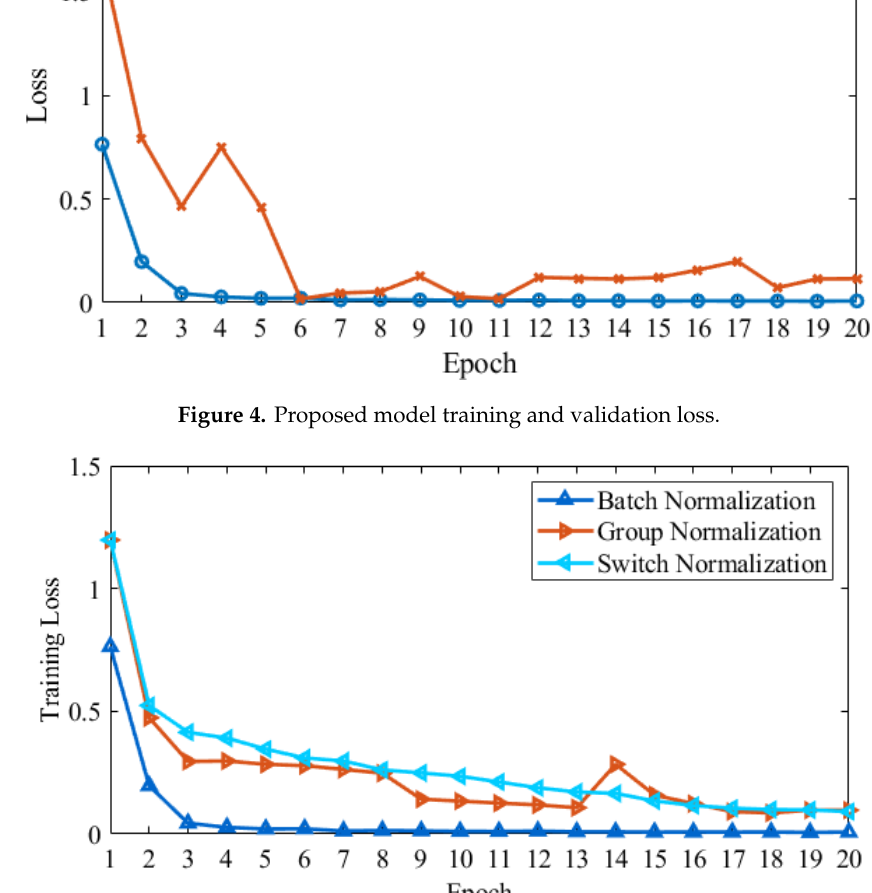
Figure 5. Training loss results with three normalization techniques on the AD dataset.